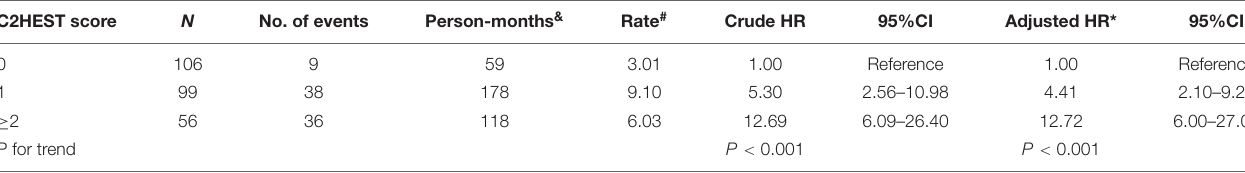
TABLE 2 | Incidence and hazard ratios of atrial fibrillation late recurrence stratified by C2HEST score.